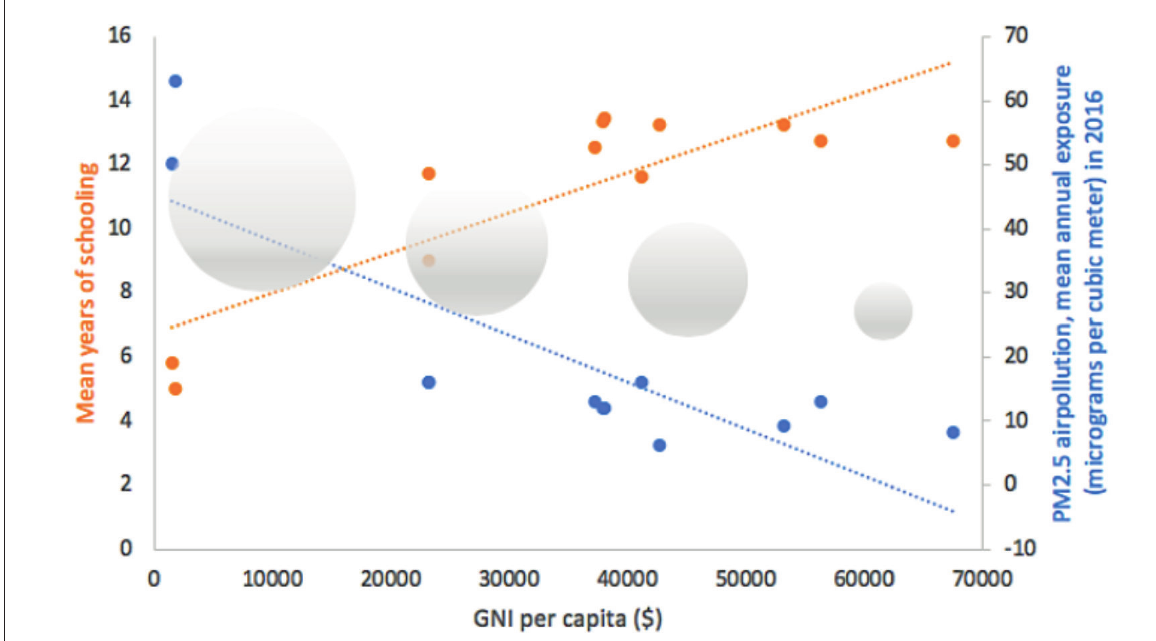
Figure 10. Interaction between level of schooling, GNI per capita and PM